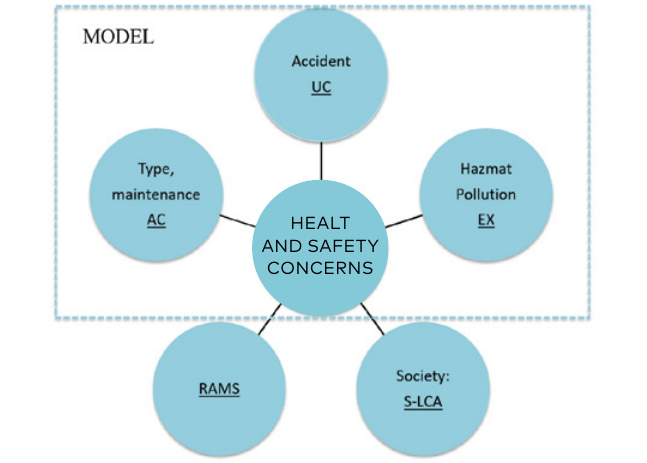
Figure 1. Health and safety issues